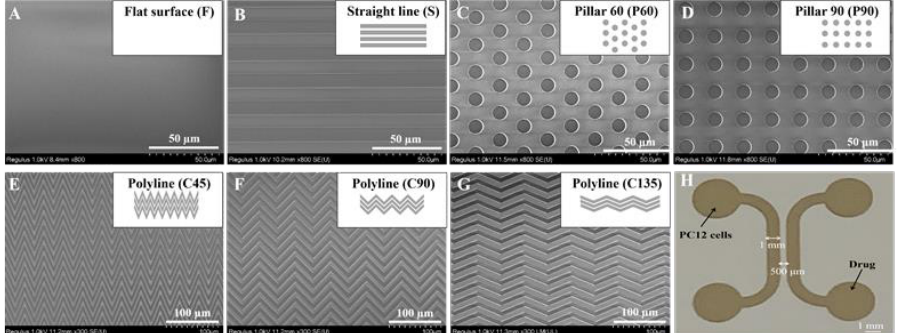
Figure 1. SEM images of PDMS replicas with different topological microstructures and images of the upper layer with the symmetric cell culture channels. ( A ) flat surface (F). ( B ) straight channel (S). ( C ) 60 ◦ distribution micropillar array (P60). ( D ) 90 ◦ distribution micropillar array (P90). ( E ) 45 ◦ polyline (C45). ( F ) 90 ◦ polyline (C90). ( G ) 135 ◦ polyline (C135). Scale bar = 50 µ m or 100 µ m. ( H ) Images of the upper layer mold with the symmetric cell culture channels. Scale bar = 1